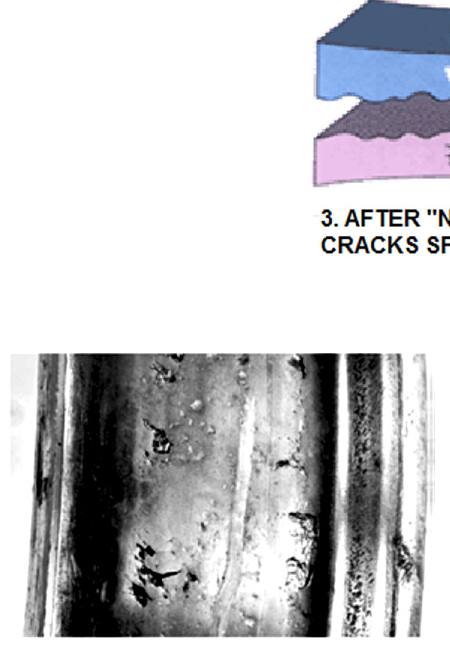
Fig. 14 Surface fatigue wear on the wheel